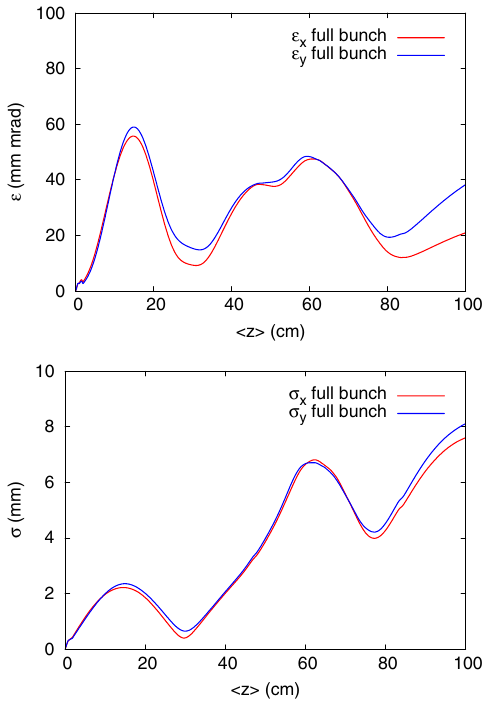
FIG. 5. Upper frame: Plot of the transverse emittances (cid:8) mm mrad as a function of h z i in cm for an energy selection of the beam 29 < E < 31 MeV . Lower frame: Plot of the rms beam , (cid:4) in mm for the same energy selection. The focus of sizes (cid:4) x y the solenoid for this quasimonoenergetic beam is at z ¼ 83 cm .